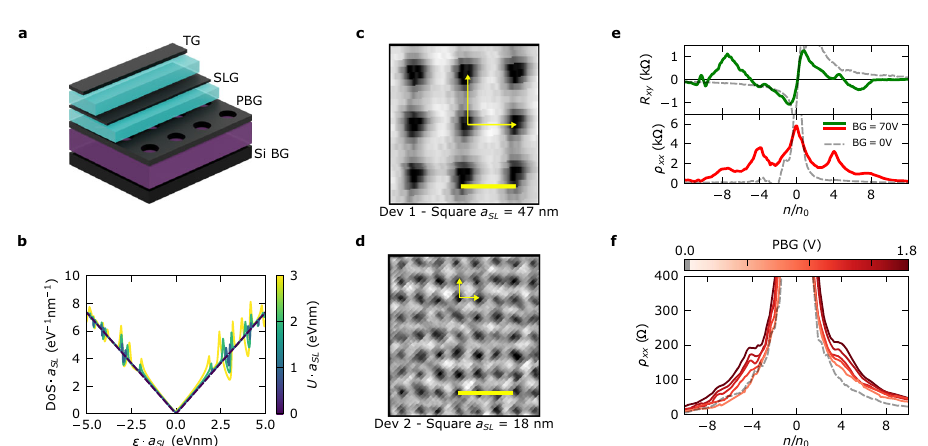
Fig. 3 | Electronic transport characterization of devices Dev 1 and Dev 2. a Heterostructure schematic. The main difference between Dev 1 and Dev 2 is the useofagraphitetopgateinthelatter. b Predictednormalizeddensityofstatesper superlattice (SL) length a SL , which demonstrates the invariance of the Dirac equation with the product a SL and the potential modulation U (cid:1) a SL . c , d Atomic force microscopy (AFM) topography images of the patterned graphite gates used for each device. The scalebars are 50nm. e Longitudinal resistivity (red trace) and Hallresistanceat B =0 : 1 T(greentrace)asafunctionof the electrondensityperSL unitcell for Dev 1 (silicon backgate voltage V BG =70 V). Gray dashed traces display